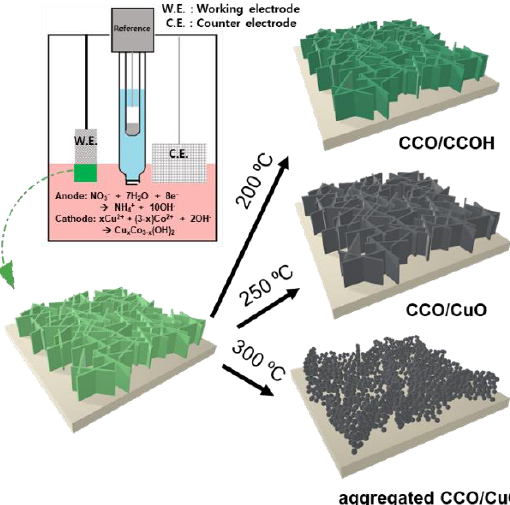
Figure 1. Schematic illustration of CCO catalyst preparation using electrodeposition and heat treatment at 200, 250, and 300 °C.